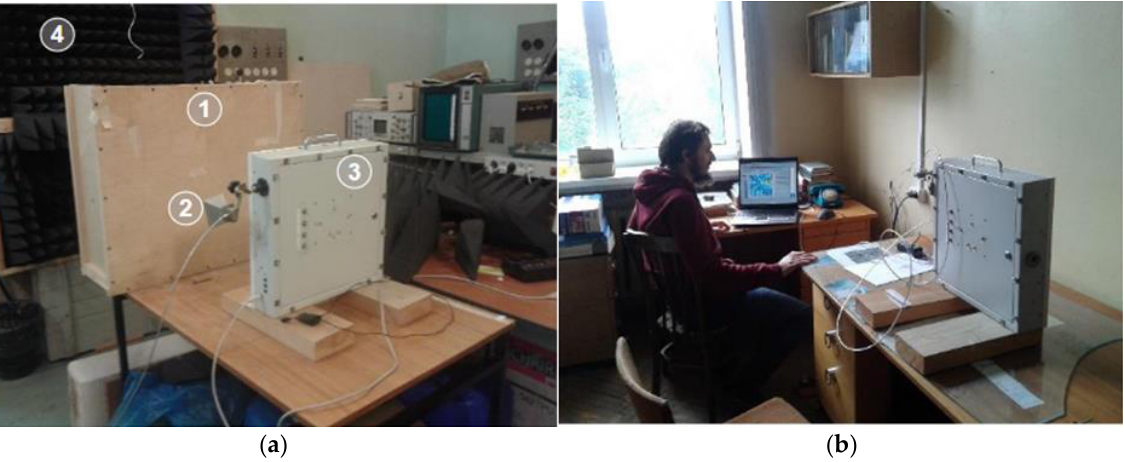
Figure 4. VNIISMI prototype of holographic subsurface radar. ( a ) Horn transmitter antenna attached to the receiver antenna block. ( b ) Realistic through-wall vision experiment.